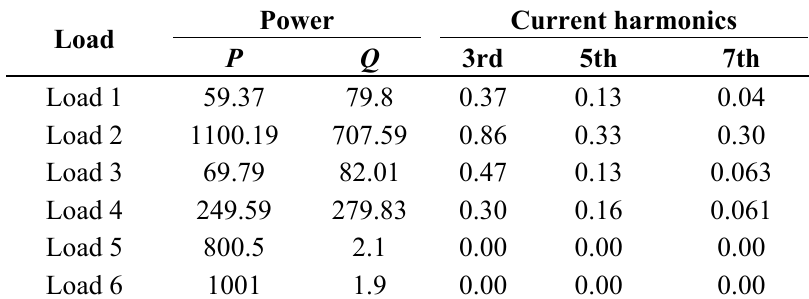
Table 4. Estimated feature parameters.